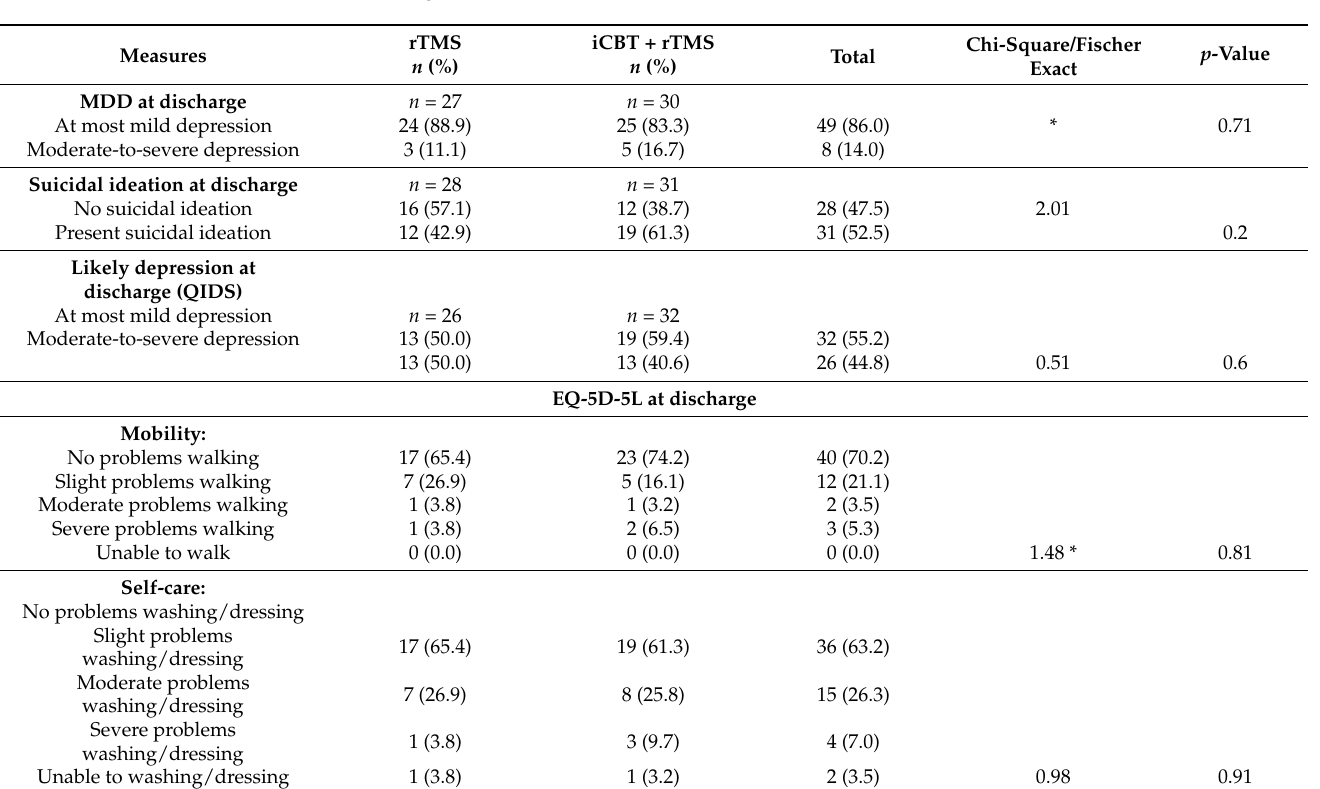
Table 3. Distribution of the prevalence of the clinical characteristics between the two study groups at